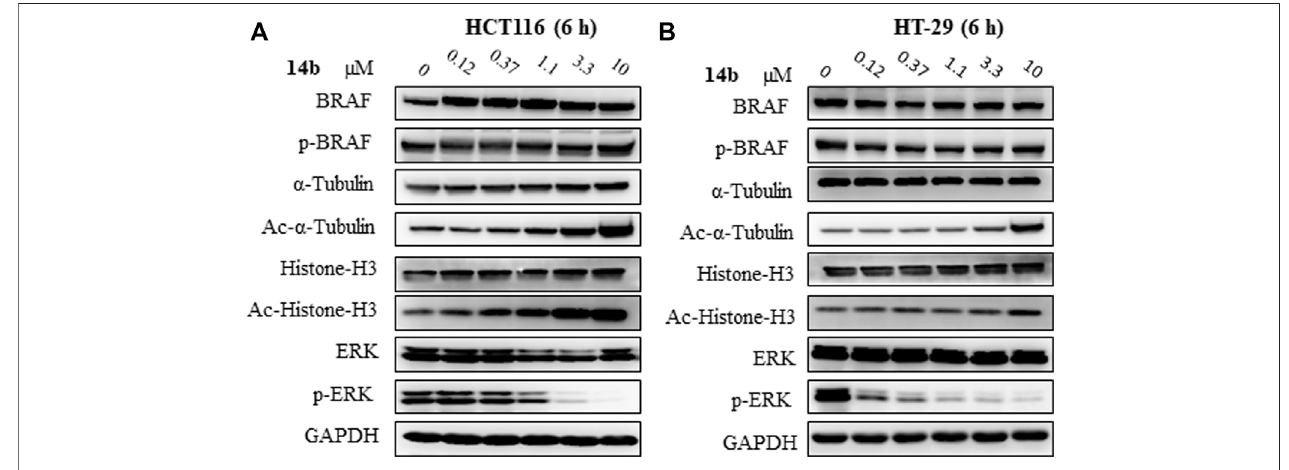
FIGURE 3 | Characterization of dual inhibition of HDAC and RAF pathway. Western blot analysis of 14b in HCT116 cells (A) and in HT-29 cells (B) . Cells were treated with 0 μ M, 0.12 μ M, 0.37 μ M, 1.1 μ M, 3.3 μ M, and 10 μ M of drugs and incubated for 6 h. The cell lysis was subjected to Western blot analysis.